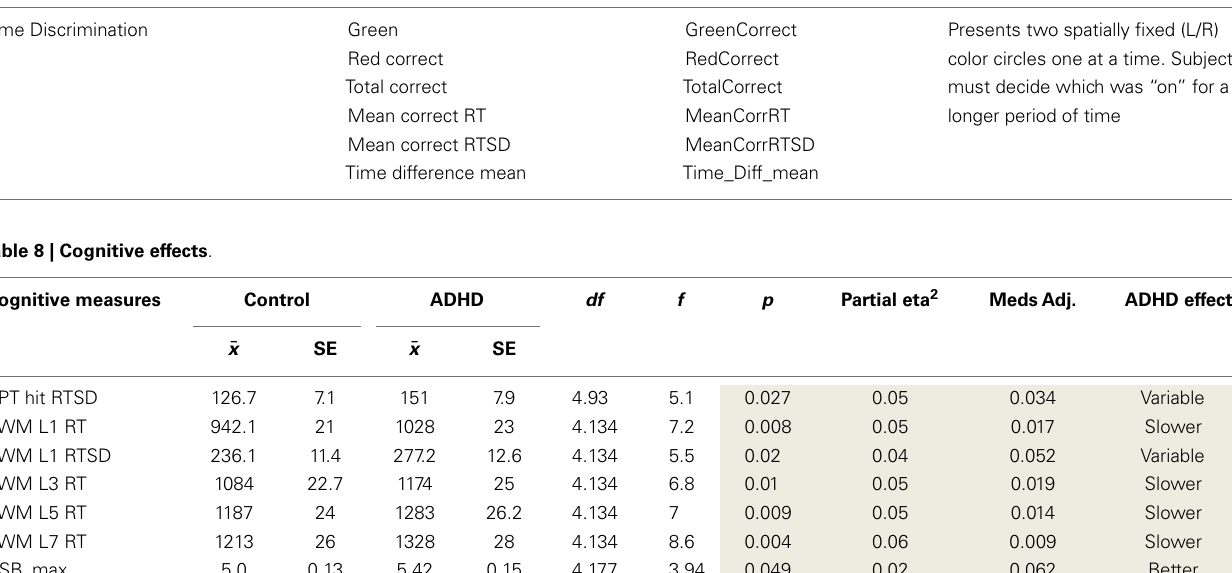
Table 7 for description of cognitive